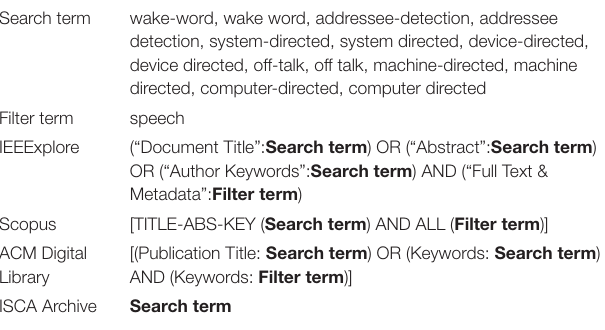
TABLE 1 | Search parameters used in this